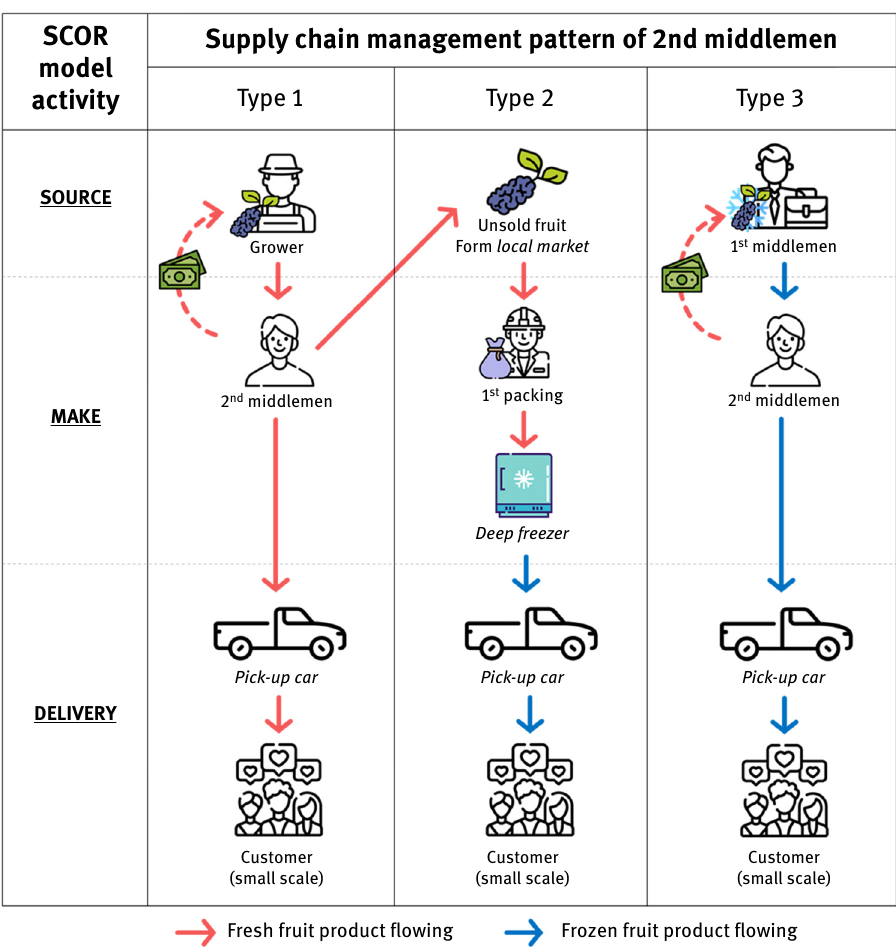
Figure 3: Secondary middle patterns in mulberry supply chain